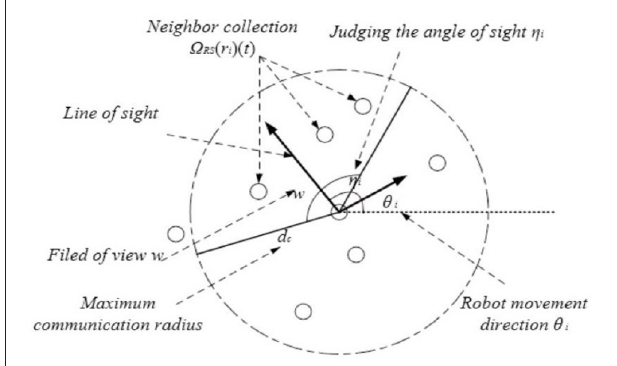
FIGURE 3 | Schematic diagram of individual neighbor